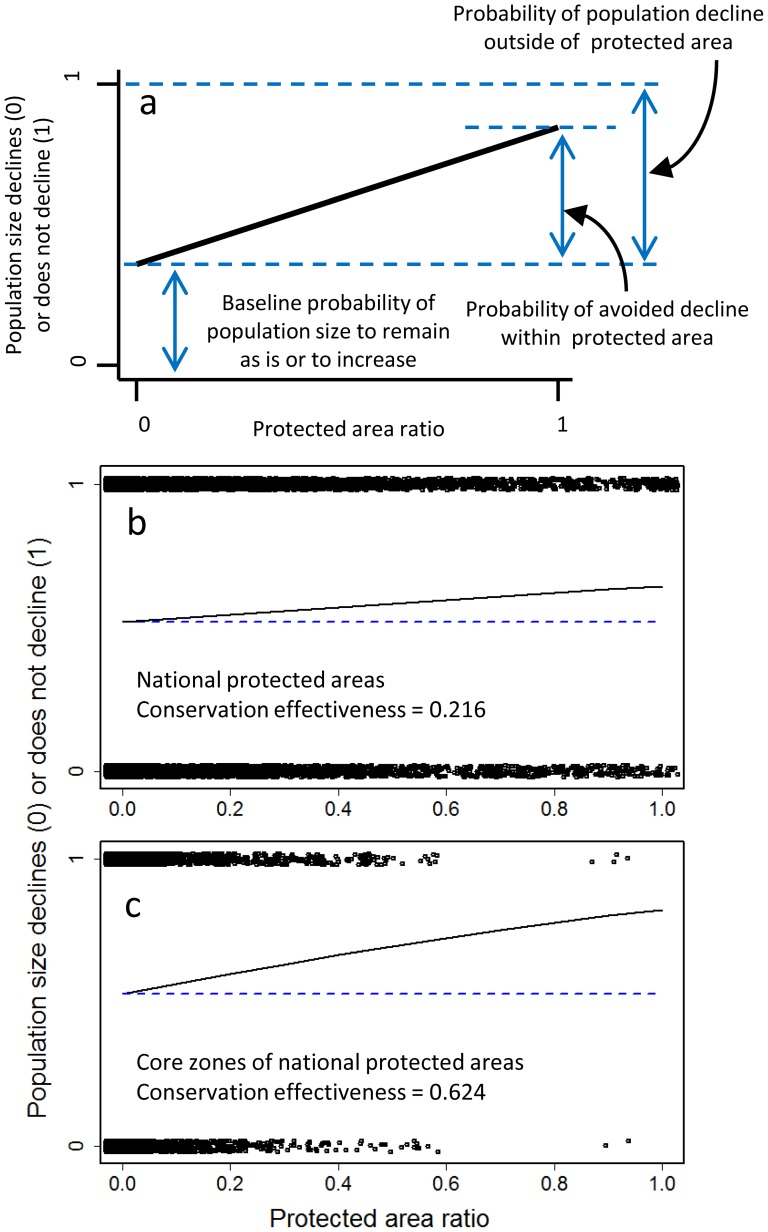
Relationships between the ratio of protected area in a cell and local population decline (defined as either decreased [0] or constant or increased [1]).(a) Conservation effectiveness is calculated as the ratio of the probability of avoided decline within a protected area to the probability of population decline outside the protected area. (b) Empirical assessment using total protected area, which corresponds to natural parks with regulations for biodiversity conservation (27 747 km2: ca. 7.3% of Japan). (c) Empirical assessment using core zones of the national parks (3449 km2: ca. 0.91% of Japan). Dark blue dashed line represents baseline probability of avoided decline in cells where protected area = 0%.